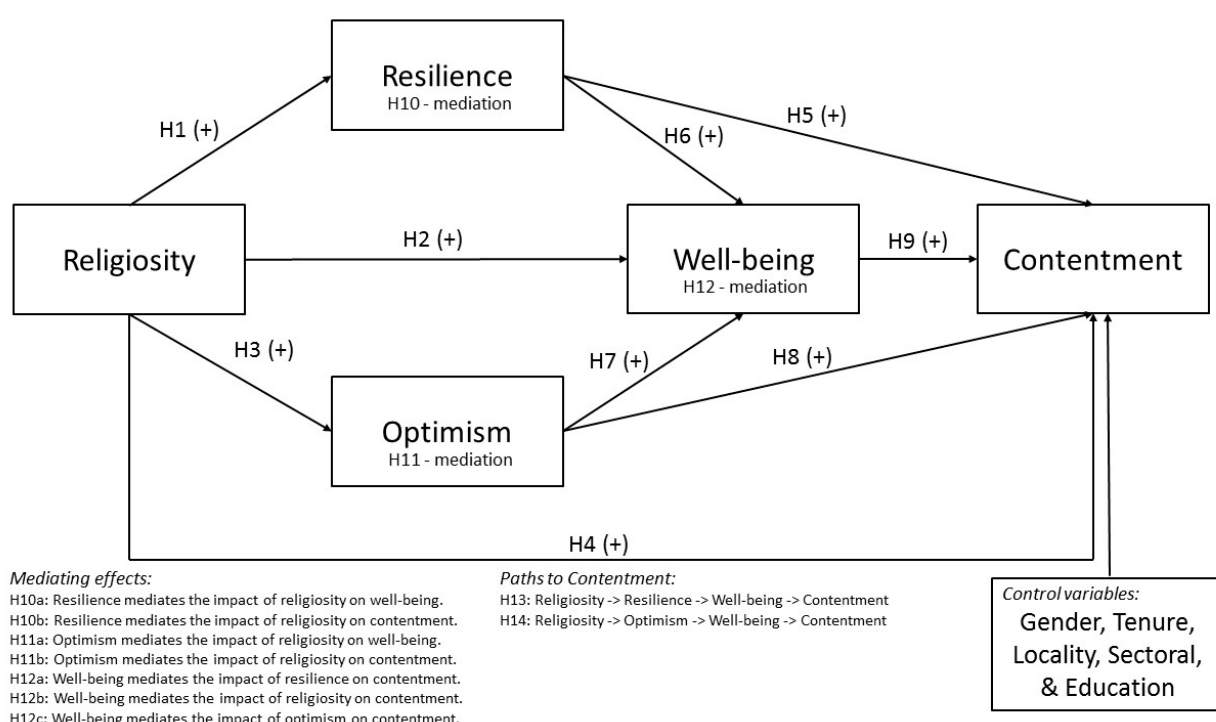
Figure 1. Structural framework.